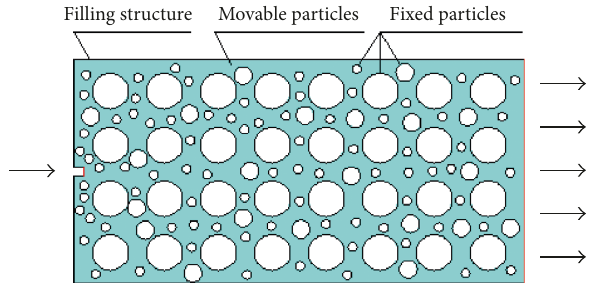
Figure 2: Details of structural model